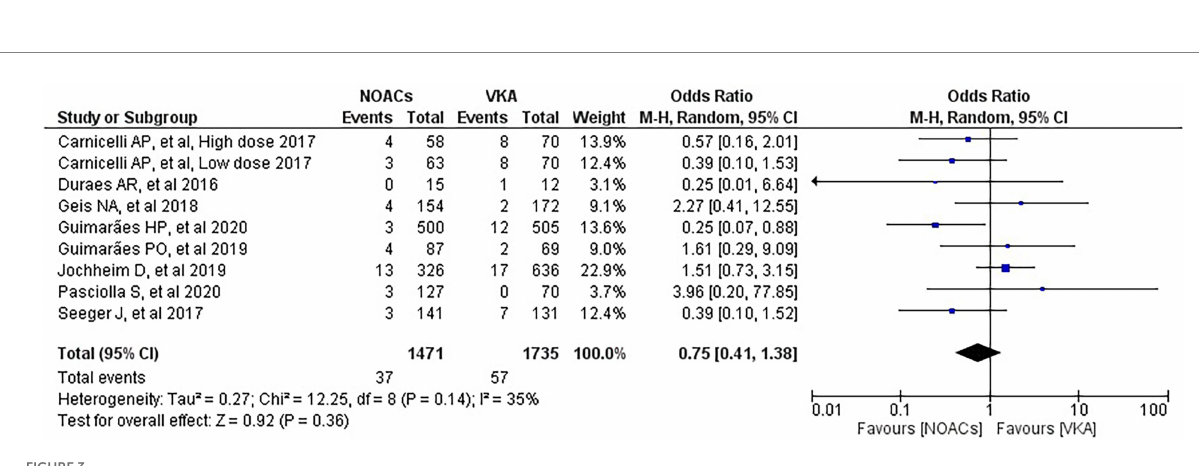
FIGURE 3 Forest plot of stroke for DOACs compared with VKA. M-H, Mantel–Haenszel test; CI, confidence